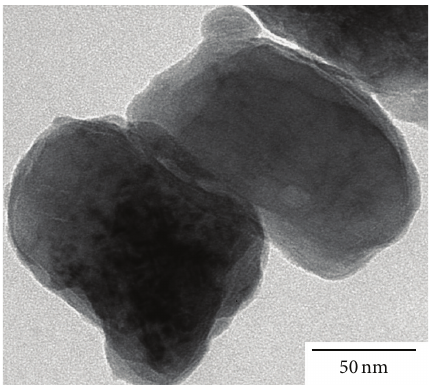
Figure 2: TEM micrograph of the MgB 2 powder in as-prepared